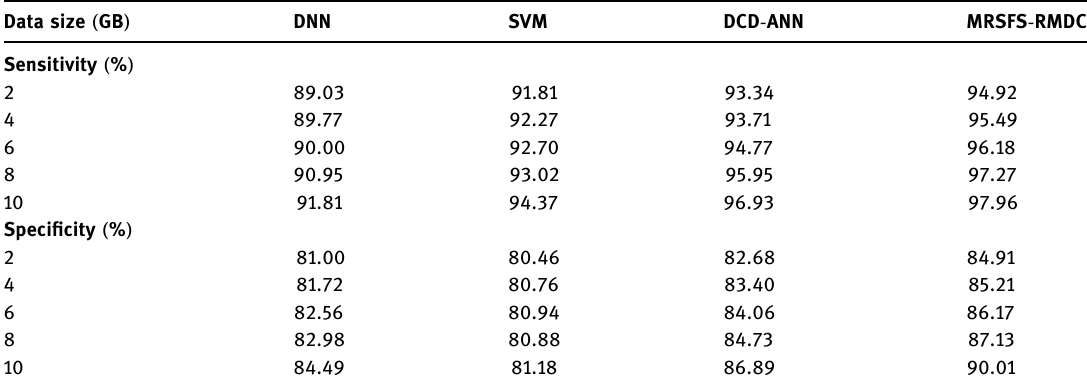
Table 1: Result analysis of MRSFS - RMDC model with di ff erent data